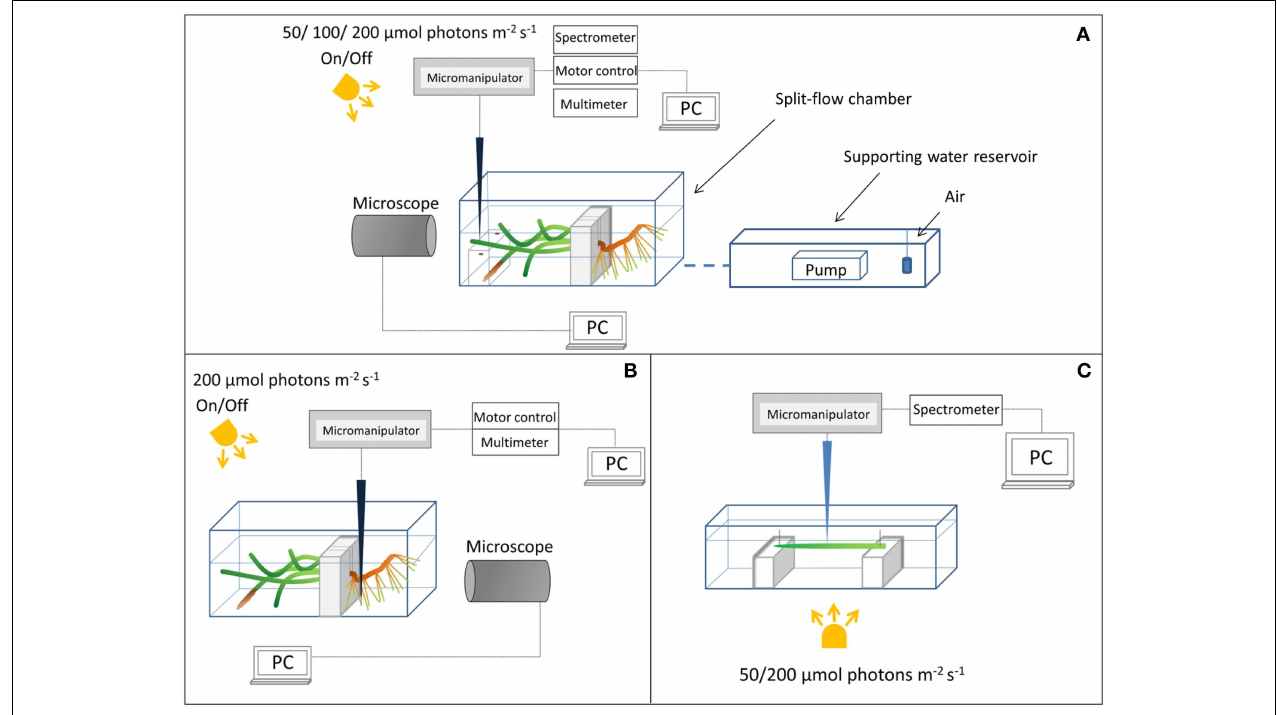
FIGURE 1 | Schematic diagram of the experimental setups. (A) Above-ground light and O 2 microsensor measurements. (B) Measurements on the below-ground chemical microenvironment with Clark-type O 2 microsensors. (C) Measuring light transmission spectra at the seagrass leaf surface.